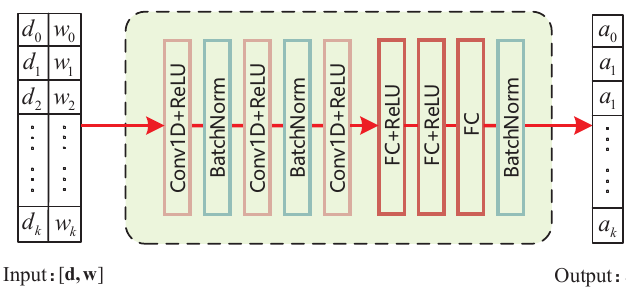
Figure 4. The process of the DSLO-CNN